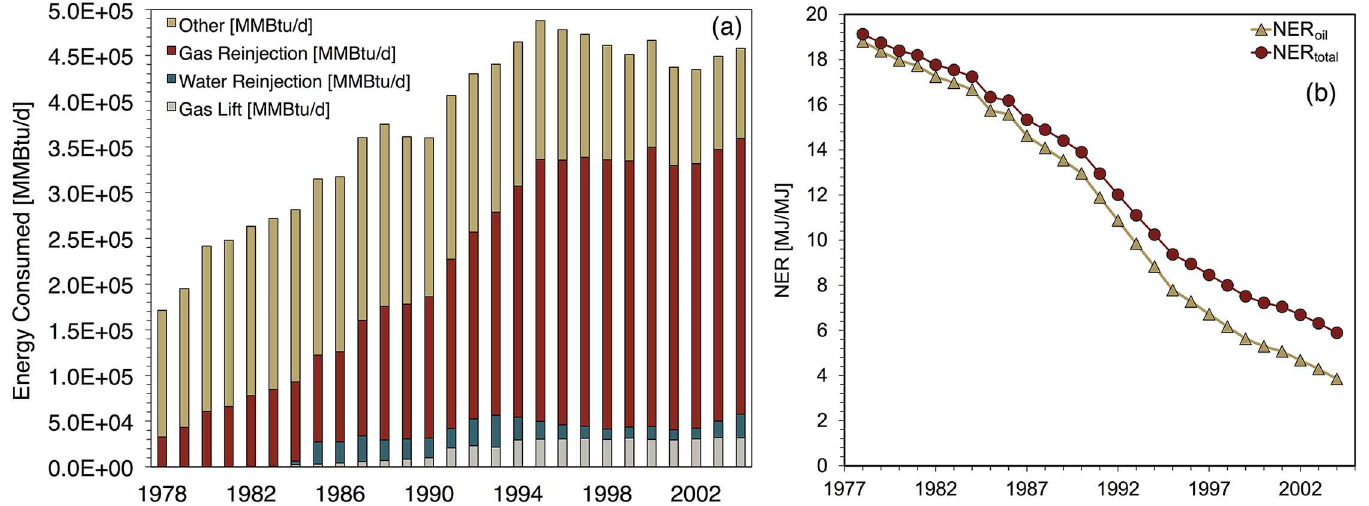
Fig 10. Prudhoe Bay base caseresults showing (a) total energy inputs for major processes (b) NER